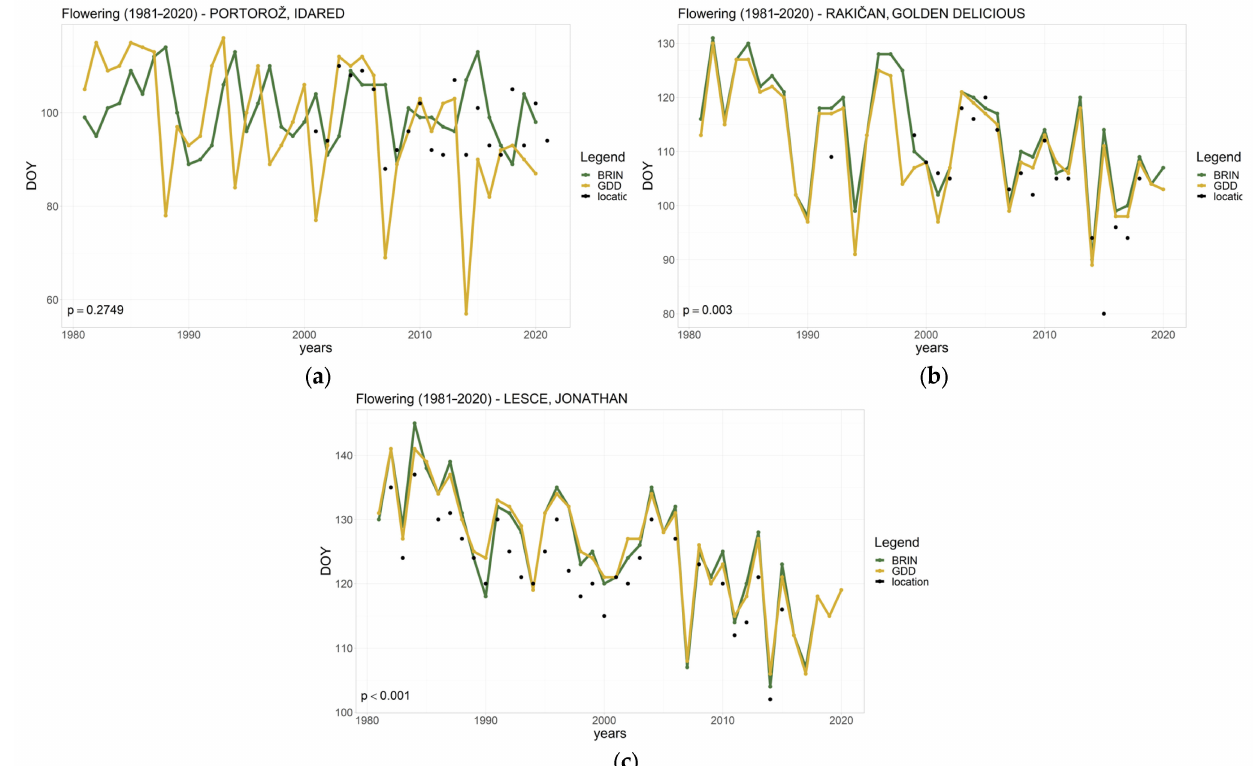
Figure 3. Modeled and observed budburst dates of three apple varieties: ( a ) Idared at location Por- torož (sub-Mediterranean climate); ( b ) Golden Delicious variety at location Rakiˇcan (subcontinental climate); and ( c ) Jonathan variety at location Lesce (moderate climate of the hilly region). Yellow lines indicate results obtained with GDD, green lines indicate results obtained with the model, and black dots indicate the observed budburst date according to the Slovenian Environment Agency dataset. Added is the statistical significance (p) of the trend in observed budburst dates, calculated with the Mann–Kendall test, and day of year is denoted as